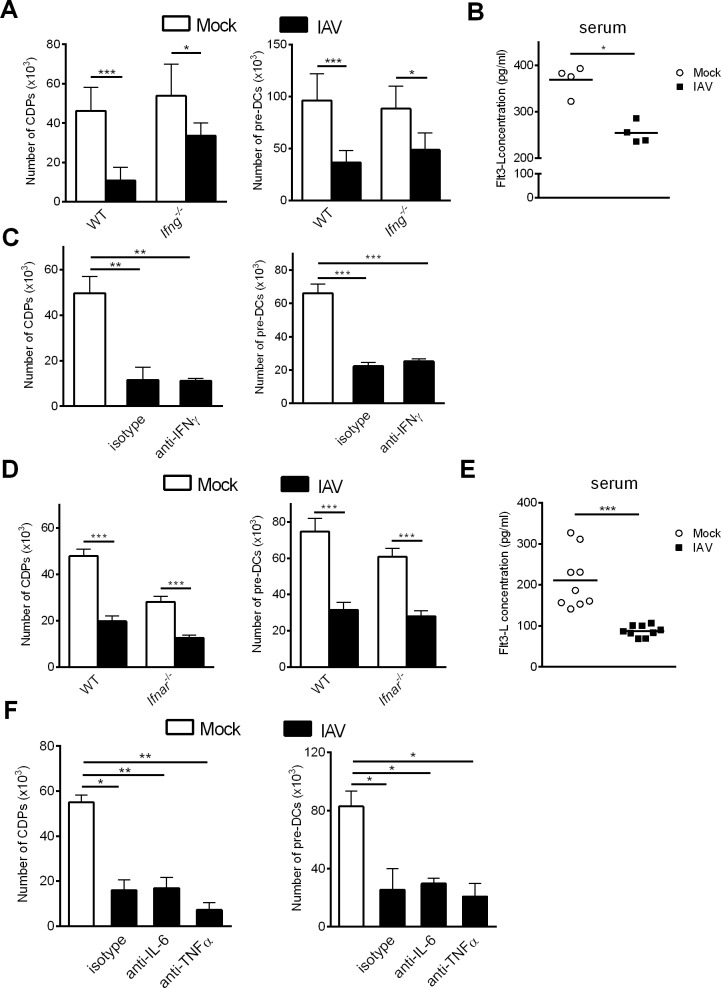
Neutralization of pro-inflammatory cytokines does not restore the DC progenitor compartment during IAV infection.(A) Age- and sex-matched WT and Ifng-/- mice were infected (or not) i.n. with H3N2 virus. (B) Production of Flt3-L was quantified in the serum of Ifng-/- mice infected or not with IAV (7 dpi) (n = 4). (C) Infected WT mice were treated at day 0, 2, 4 and 6 pi with anti-IFN-γ mAb or isotype control (300μg/mouse). (D) Age- and sex-matched WT and Ifnar-/- mice were infected or not with IAV. (E) Production of Flt3-L was quantified in the serum of Ifnar-/- mice infected or not with IAV (7 dpi) (n = 9). (F) Infected WT mice were treated at day 0, 2, 4 and 6 with anti-IL-6, anti-TNFα or isotype (300μg/mouse). (A, C, D, F) The absolute number of BM CDPs and pre-DCs were assessed by flow cytometry at 7dpi. (A, C) Means ± SEM of biological replicates from two or three experiments are shown (n = 9–12). (D) Data are pooled from three experiments (n = 10–15). (F) Means ± SEM of biological replicates are shown (n = 5). *, p < 0.05; **, p < 0.01; ***, p < 0.001.